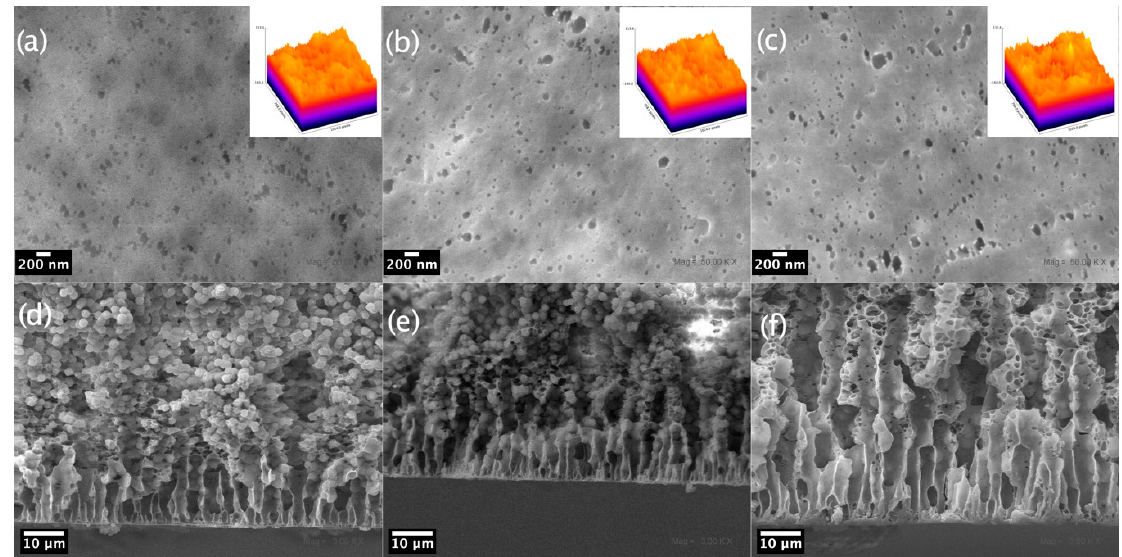
Figure 7. Surface ( a – c ) and cross-section ( d – f ) SEM micrograph images of PVDF composite membranes prepared at 2% ( a , d ), 5% ( b , e ), and 10% ( c , f ) CuONPs@CF. The insets in the upper row show 3D color surface roughness profiles (x = 768 px; y = 1024 px; z(intensity): − 160 to 113)).